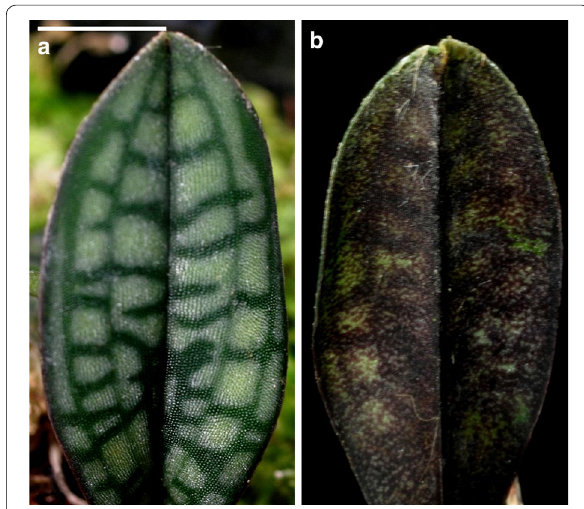
Fig. 2 Leaf morphology of P. rungsuriyanum . a The adaxial surface of leaves. Scale bar 5 mm. b The abaxial surface of leaves. Scale bar 5 mm